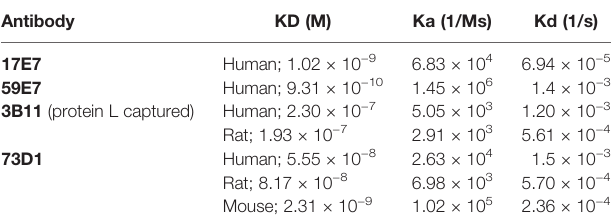
FIGURE 3 | Western blotting to detect C7 binding in serum and in TCC. (A) The human-speci fi c mAbs 59E7 and 17E7 were used to probe WB of NHS (Hu) and Cynomolgus monkey (Mk) serum under non-reducing (NR) conditions. Secondary only control was included (2°). (B – E) The cross-species reactive mAbs 73D1 (B) , 3B11 (C) and 2H2 (D) and as control the polyclonal goat anti-C7 (E) were used to probe WB of NHS (Hu), monkey (Mk), mouse (Mo) and rat sera; puri fi ed human C7 was used as standard. All sera were run in duplicate. Polyclon3B11 (C) , 2H2 (D) , and positive control goat anti-C7 (E) . Results are representative of three independent experiments. M; protein molecular weight marker. (F – J) The novel mAbs were used to pull down complexes from activated serum; these were then run on WB under non-reduced and reduced conditions and probed with polyclonal antibodies against each of the terminal complement proteins. mAb 2H2 was used in rat (F) and human (G) serum; the other mAbs in human serum only (H – J) . The blots were cut into strips prior to probing to detect the individual terminal pathway proteins. Molecular weights used were: NR: C5, 190 kDa; C6, 105 kDa; C7, 95 kDa, C8 ag ; 70 kDa; C9, 65 kDa. R: C6, 110 kDa; C7, 95 kDa; C5 b , 75 kDa; C9, 70 kDa; C8 a / b , 65 kDa; C8 g , 22 kDa. Results are representative of at least three analyses. M; protein molecular weight marker, 2°; secondary antibody. (K) The novel mAbs 17E7, 59E7 and 73D1 were separately immobilized on mouse IgG capture sensor chips (GE Healthcare, # BR-1008-38) and mAb 3B11 (IgM) on protein L Series S sensor chip (GE Healthcare #29-2051-38) at approximately 60 RU. Human, rat or mouse C7 was fl owed in HEPES-buffered saline (HBS) in a dilution range of 66 to 8 nM and interactions with the immobilized mAbs were analyzed. Sensorgrams were collected and KDs were calculated using the Langmuir 1: 1 binding model with RI values set to zero. Representative sensorgrams for 17E7 and 59E7 binding of human C7 are shown with raw data in colored lines and fi tted data in dotted line (average of 3); all binding data and analyses are included in Table 2 . The sensorgrams of clones 3B11 and 73D1 are included in Supplementary. The SPR analysis was performed in an automated manner using T200 Biacore Evaluation Software version 2 TABLE 2 | SPR analysis of the binding of C7 to the immobilized mAb. Antibody KD (M) Ka (1/Ms) Kd (1/s)